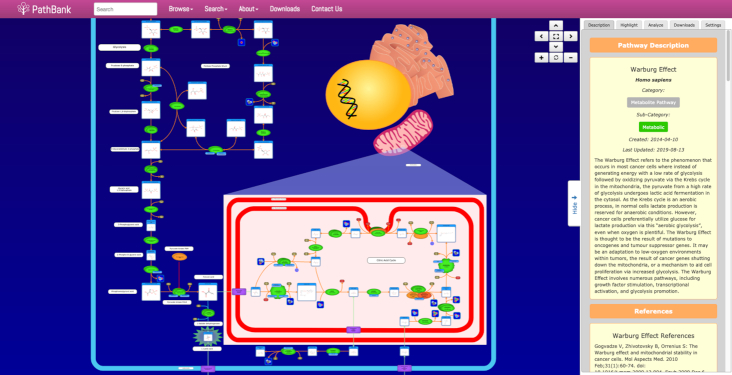
A screenshot from PathBank's ‘Warburg Effect’ pathway. First identified in the 1920’s, this is a pathway commonly activated in cancer and it is classified as a ‘Metabolite Disease’ pathway. Curiously, no other commonly used pathway database appears to illustrate this very well-known and important pathway.